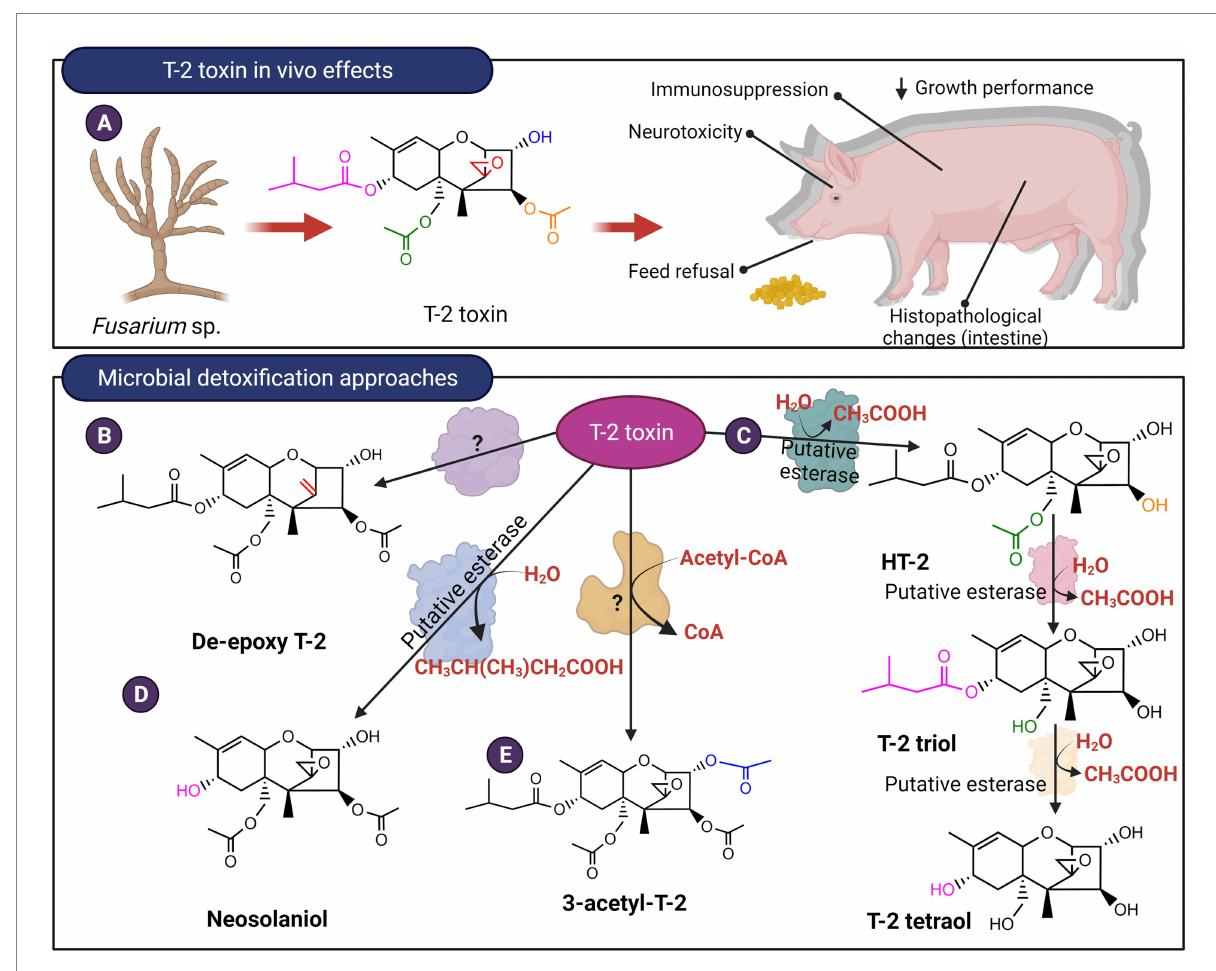
FIGURE 8 In vivo effects of Type A trichothecenes like T-2 toxin and microbial detoxification approaches. (A) T-2, like DON, causes negative gastrointestinal effects and ribotoxic stress. (B–E) The mycotoxin can be detoxified by de-epoxidation, hydrolysis of the ester linkages or